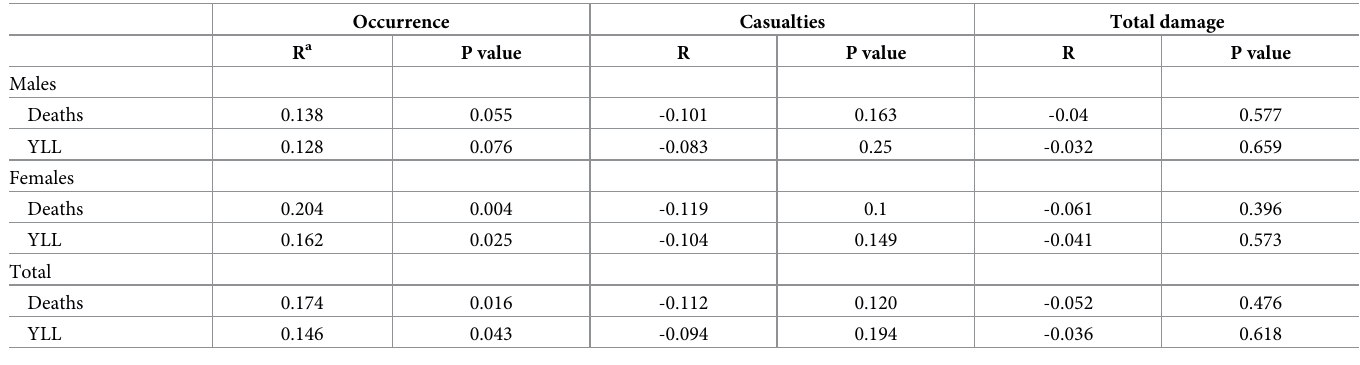
Table 2. Correlations of natural disaster impact, mortality due to IHD and YLL due to IHD during two periods in 193 countries. Occurrence Casualties Total damage R a P value R P value P